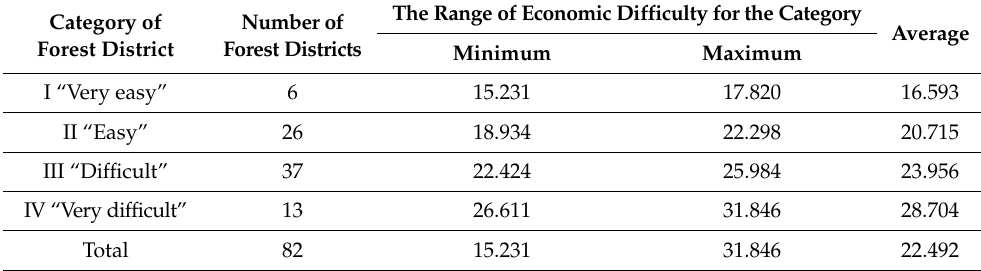
Table A8. The categories of forest districts distinguished on the basis of the level of difficulty